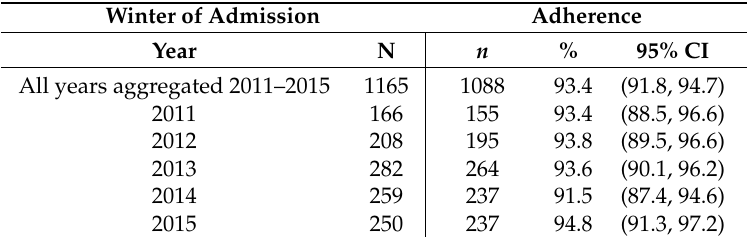
Table 3. All years aggregated and yearly adherence to the referral